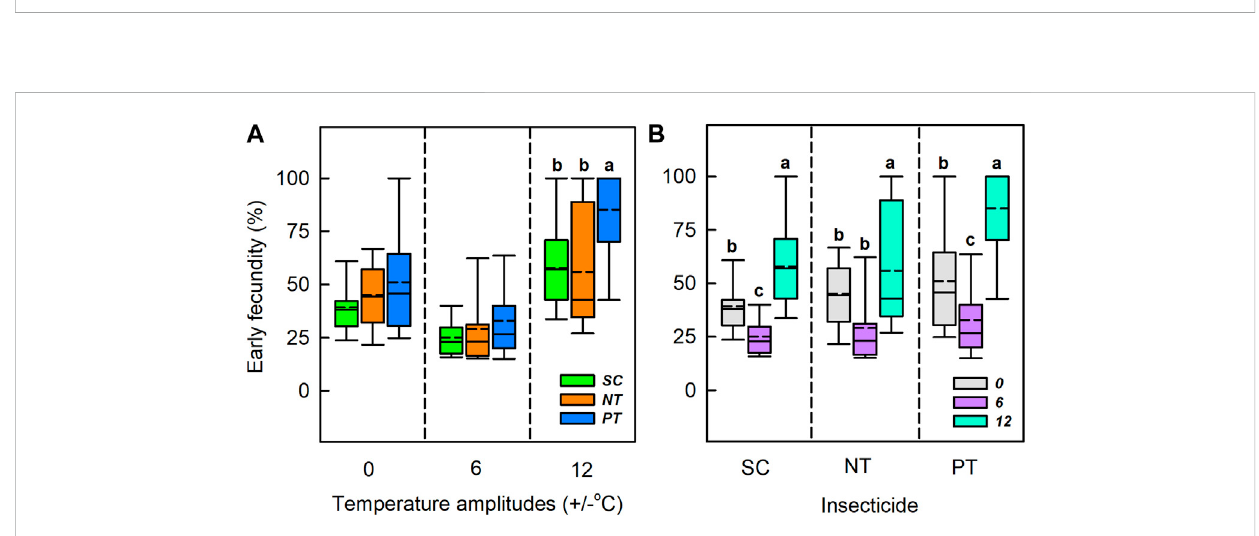
FIGURE 5 Box plot of early fecundity under various temperature amplitudes (A) and insecticides (B) . The upper and lower boundaries of the box indicate the 75th percentile and 25th percentile of the dataset. The black horizontal line and short dashed-line within the box represent the median and mean values, respectively. Error bars above and below the box indicate the minimum and maximum values, respectively. Different letters above each box indicate signi fi cant differences ( p < 0.05) among the